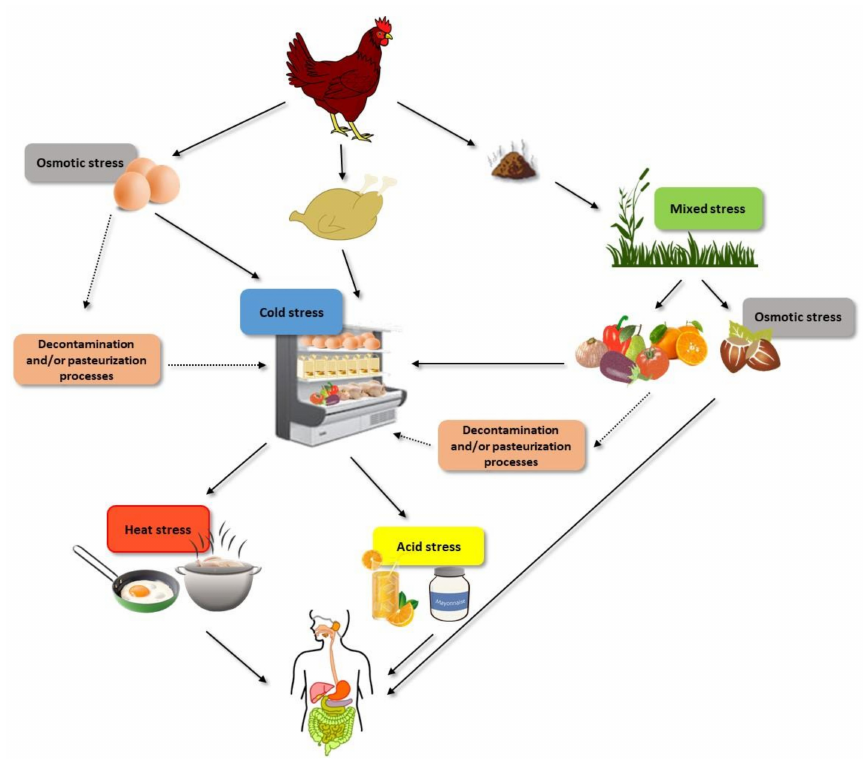
Figure 1. Examples of the different stresses that non-Thyphoidal Salmonella cells can face before being ingested with